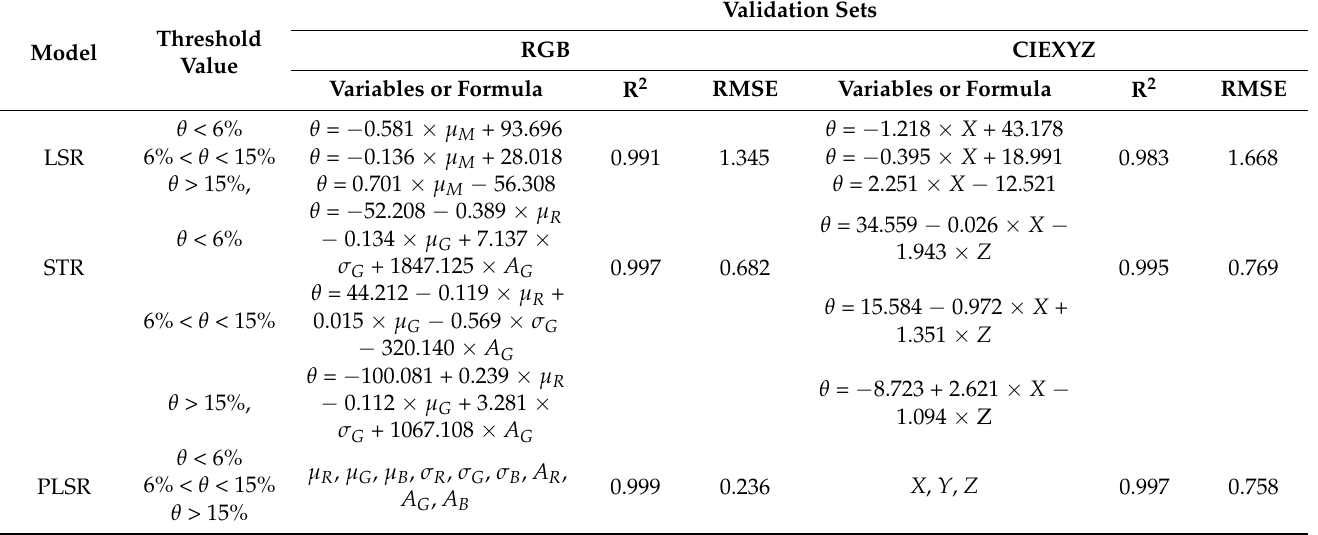
Table 4. Evaluation of different SWC predictive